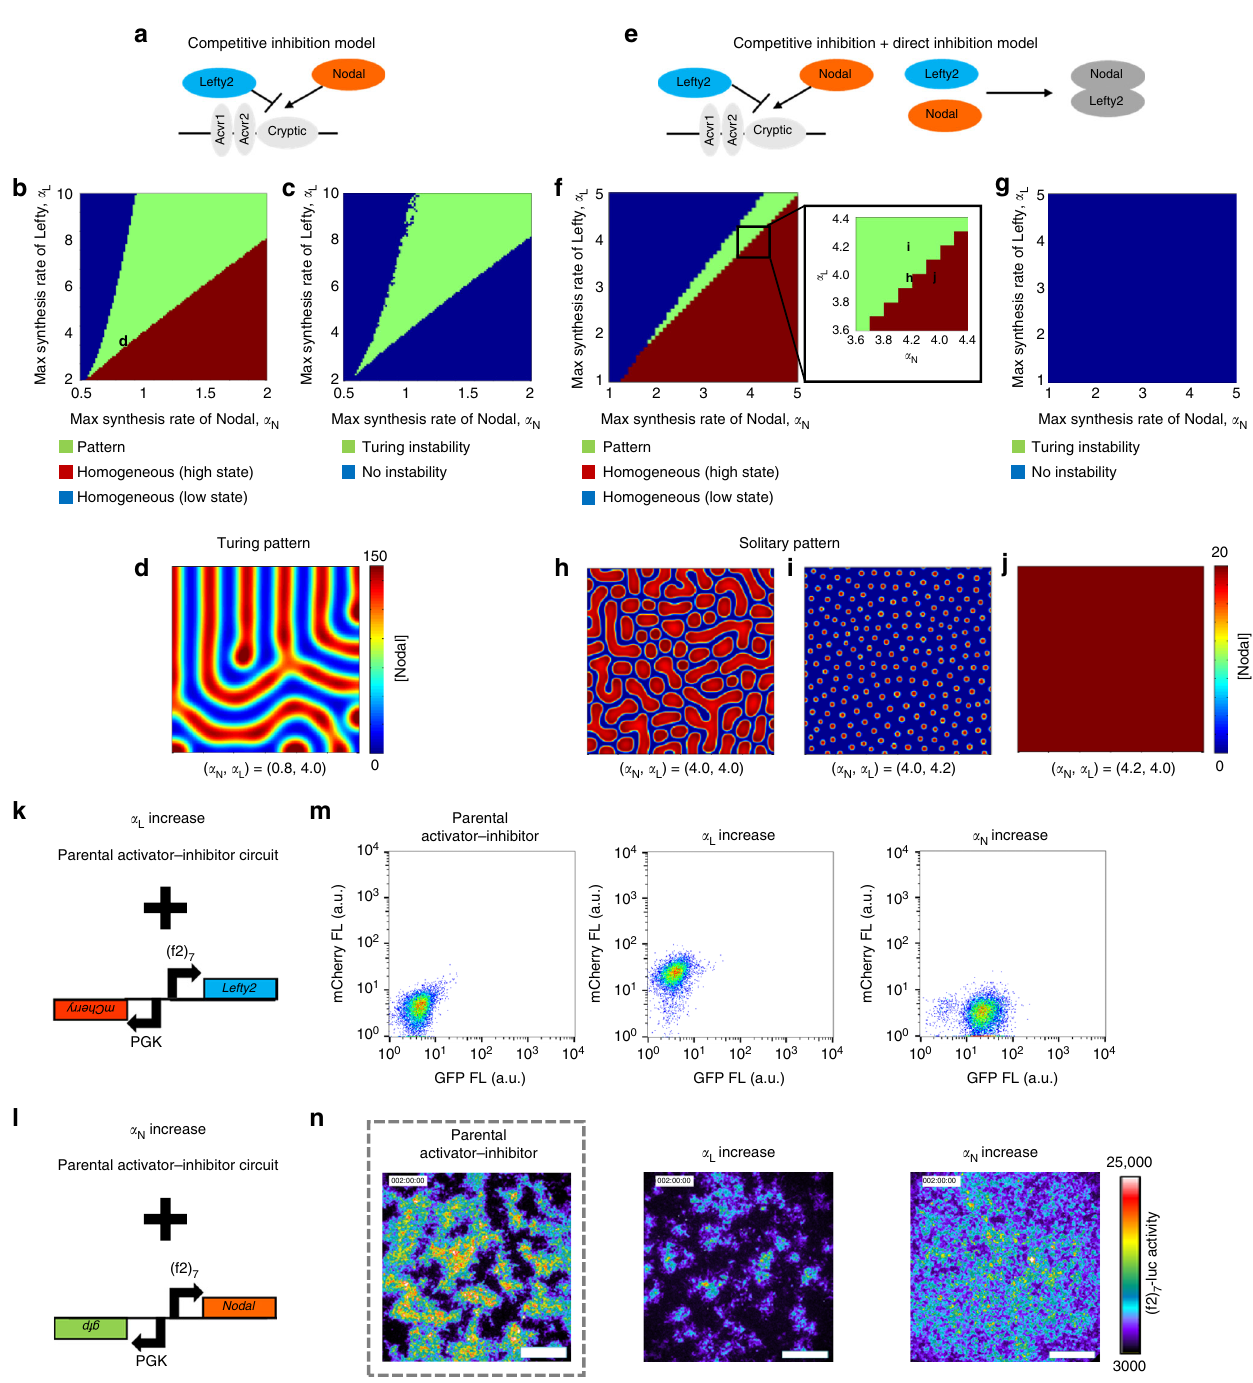
Fig. 3 Mathematical models of the activator-inhibitor circuit. a – d The competitive inhibition model. a A scheme of competitive inhibition. b The parameter region for pattern formation (green). The competitive inhibition model was simulated in one dimension. See also Methods. The parameter combination used in d is indicated by the character d. c The parameter region that meets the Turing instability condition (green). d Two-dimensional simulation with ( α N , α L ) = (0.8, 4.0). A typical Turing pattern was formed with this model and parameter set. e – j The competitive inhibition + direct inhibition model. e A scheme of competitive inhibition and direct inhibition. f The parameter region for pattern formation (green). The competitive inhibition + direct inhibition model was simulated in one dimension. The parameter combinations used in h – j are indicated in the inset. g The Turing instability condition was not satis fi ed in the entire parameter regions tested. h – j Two-dimensional simulation with different combinations of the parameters α N and α L . Solitary patterns, not Turing patterns, were formed with this model and parameter range. k To increase α L , a construct containing (f2) 7 -Lefty2 and PGK-mCherry was added to the parental activator – inhibitor circuit shown in Fig. 1d. l To increase α N , a construct containing (f2) 7 -Nodal and PGK-GFP was added to the parental activator – inhibitor circuit. m FACS plots con fi rming the introduction of the additional constructs. The mCherry signal indicates extra copies of (f2) 7 -Lefty2 ( α L increase), and the GFP signal indicates extra copies of (f2) 7 -Nodal ( α N increase). n Patterns resulting from the activator – inhibitor circuit with the increased α L or α N . The pattern of the parental activator-inhibitor cells shown in Fig. 1f is displayed as a control. Scale bars: 400 μ